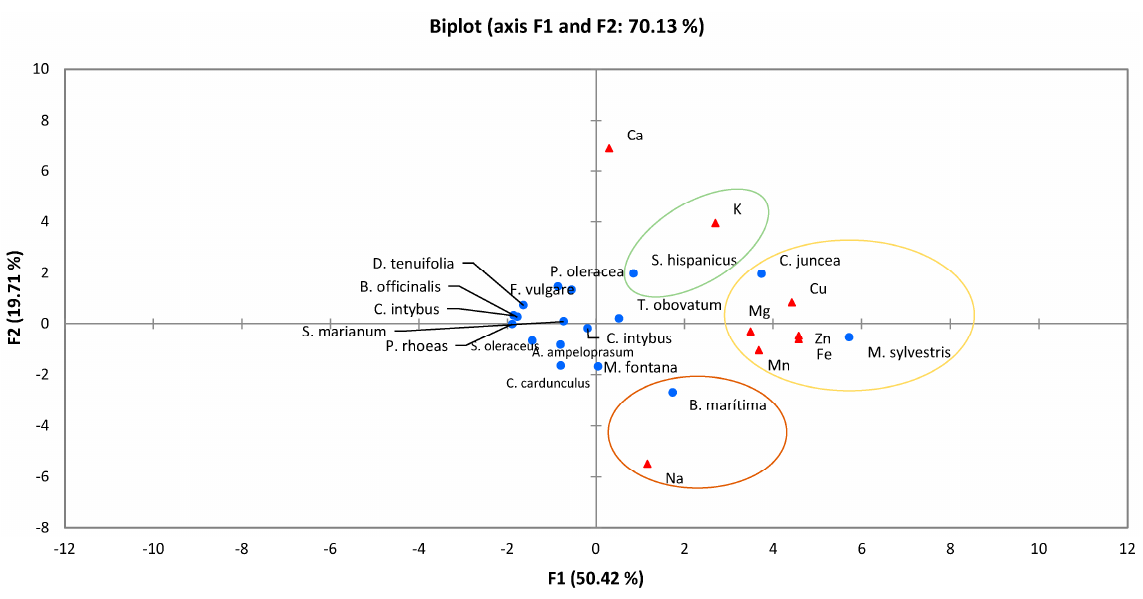
Figure 3. Principal Component Analysis of minerals present in wild edible plants,